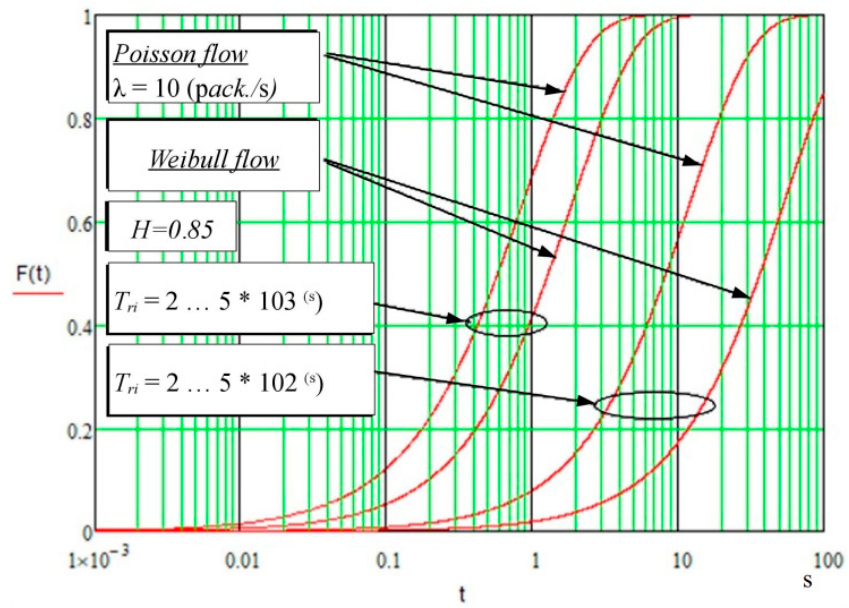
Figure 10. The graph of the distribution function of the information delivery time when λ = 20 packets/s in the context of a malefactor’s impact.